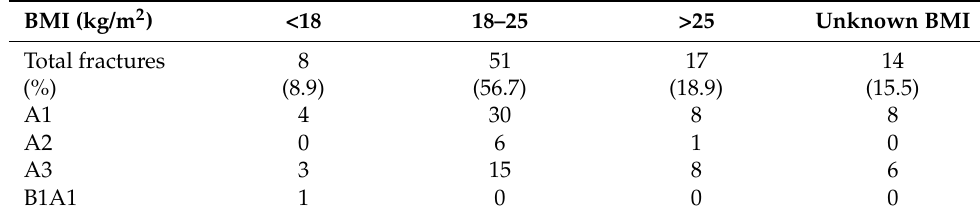
Table 4. Fracture distribution related to